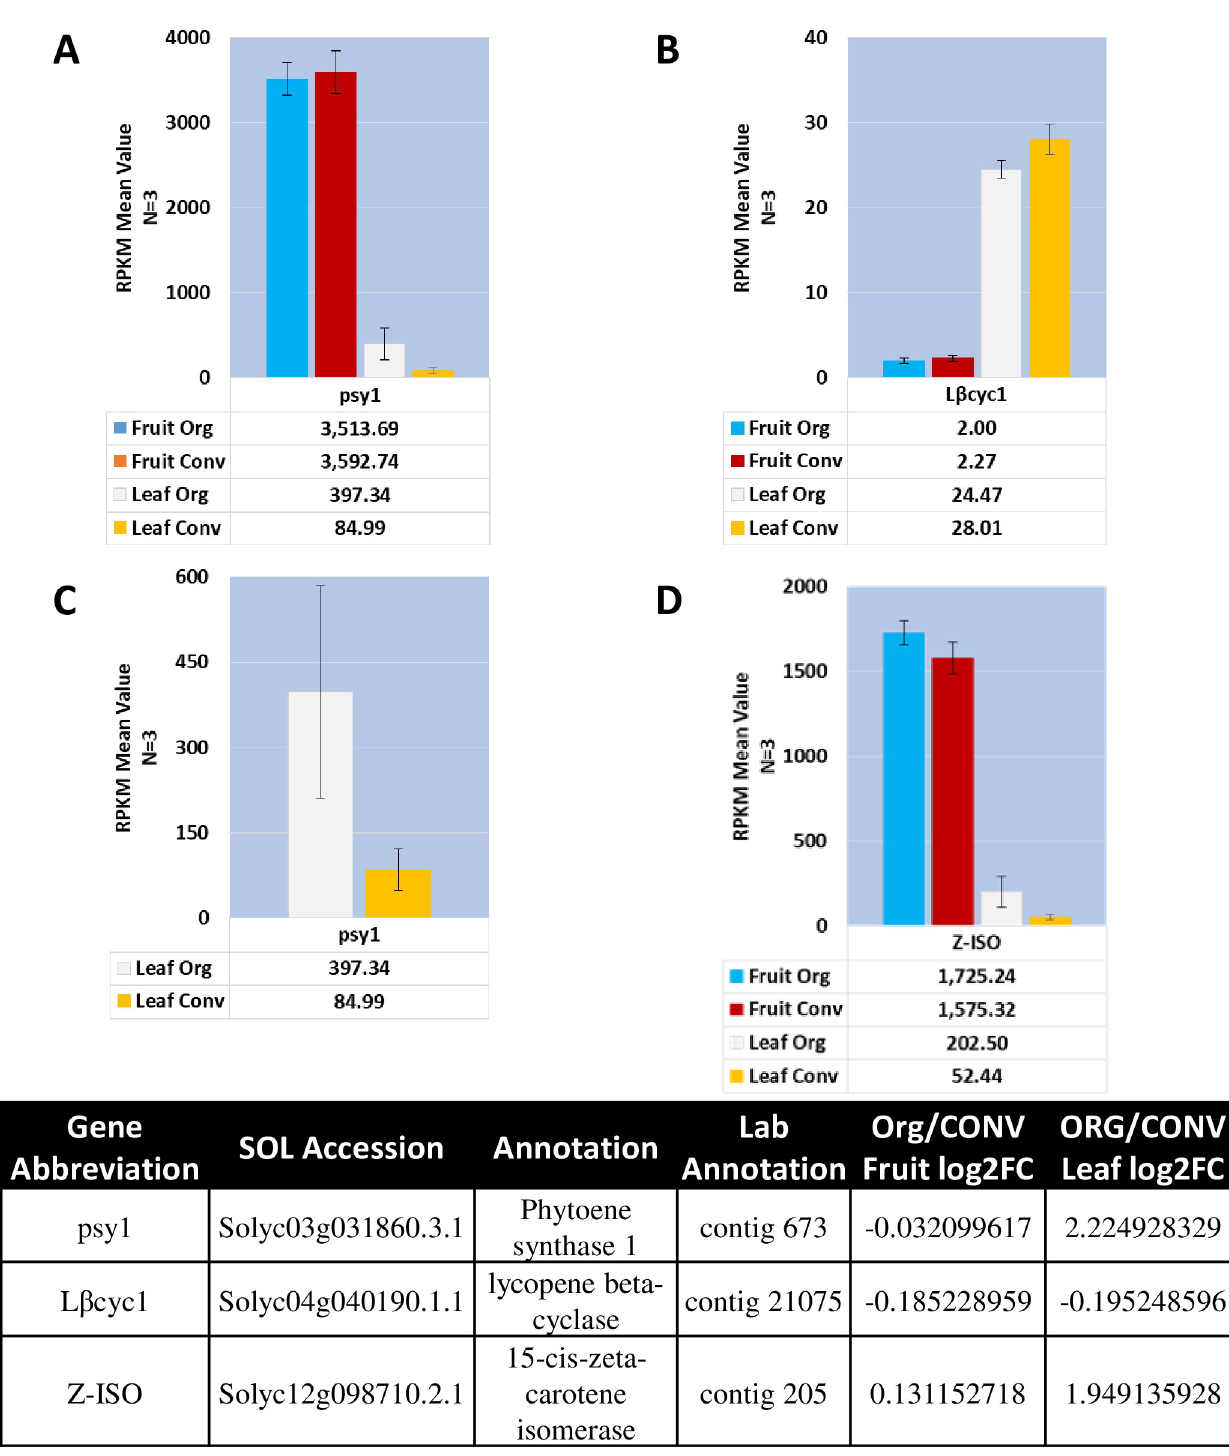
Fig 2. Mean expression profile of the Lycopene pathway committed steps and significant differential enzymes. PSY1 is the rate limiting step in the carotenoid biosynthesis pathway and the absence of L β CYC in the pathway increases the pool of lycopene from the pathway. A. psy1 RPKM expression values. B. L β cyc1 RPKM expression values. C. psy1 leaf expression values with a different y-axis to discern standard error differences. D. Z-ISO leaf expression values. Table of annotations and accession numbers from Sol Genomics ITAG3.2. Error bars denote the standard error of sequenced expression values between 3 biological